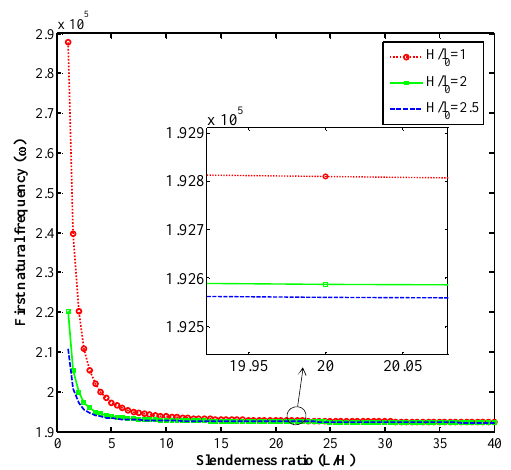
Fig. 2. The influence of nanocomposite beam length on the first natural frequency.